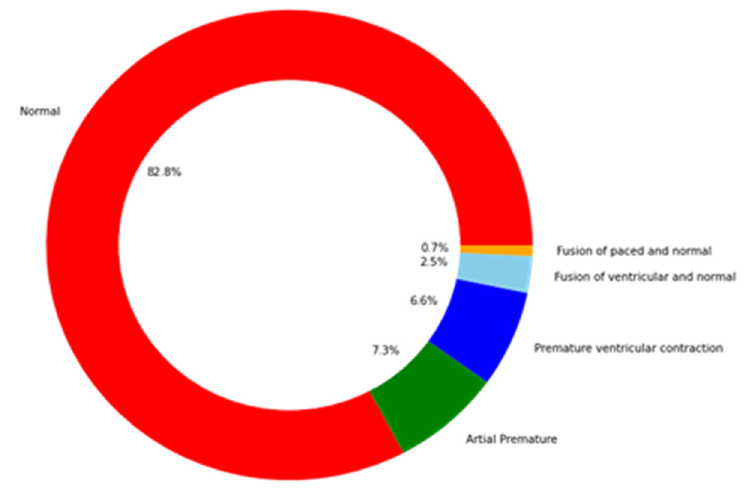
Figure 5. MIT-BIH dataset class distribution for the training data.